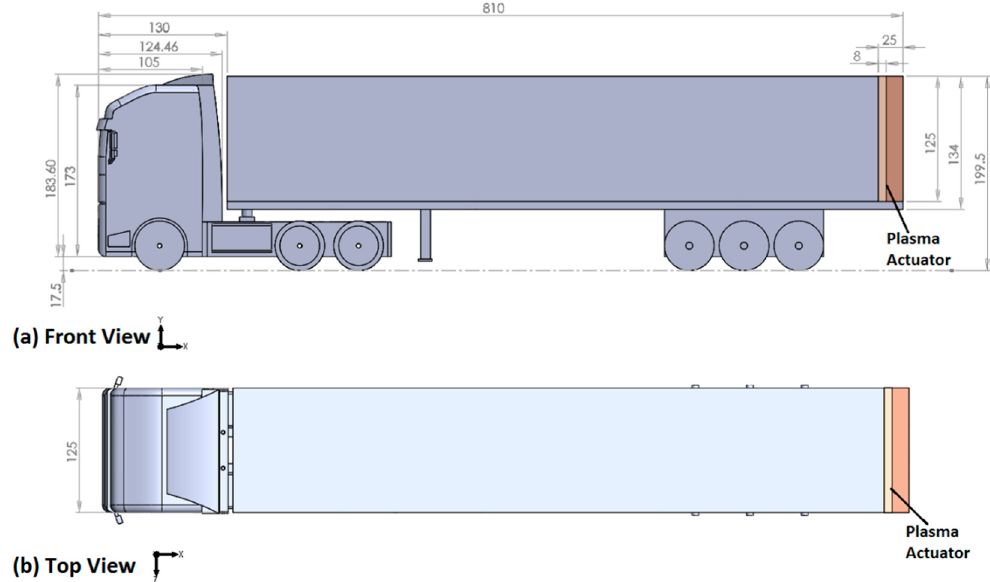
Figure 1. Schematic of the articulate lorry model (adopted and modified from [30]). Note: all units are in mm. ( a ) Front view and ( b ) side view.